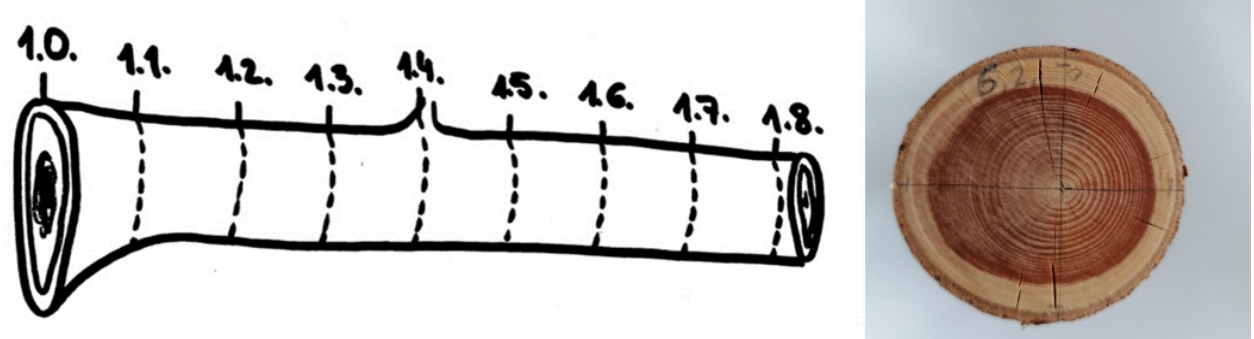
Figure 3. Left —a presentation of where silver fir samples of sawdust were collected from the branch; right —a presentation of how the sapwood and hardwood measurements were taken.